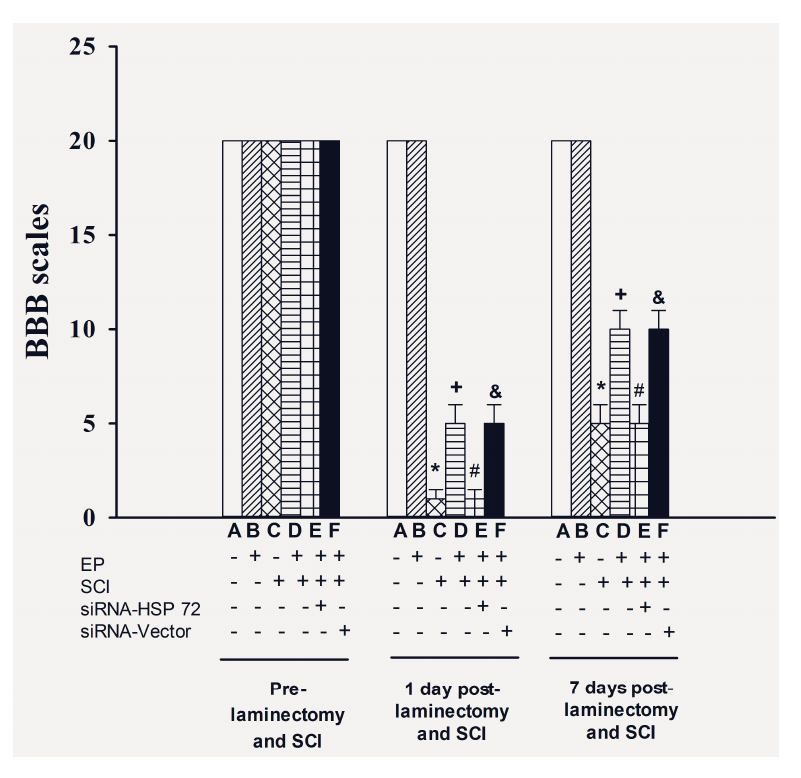
Figure 3. Effect of exercise on functional recovery following SCI. Data represent mean ± SD ( n = 8 per group). * p < 0.001 for C group vs. A group; + p < 0.05 for D group vs. C group; # p < 0.05 for E group vs. D group; & p < 0.05 for F group vs. E group. Please see the legends of Figure 1 for the explanations of the group